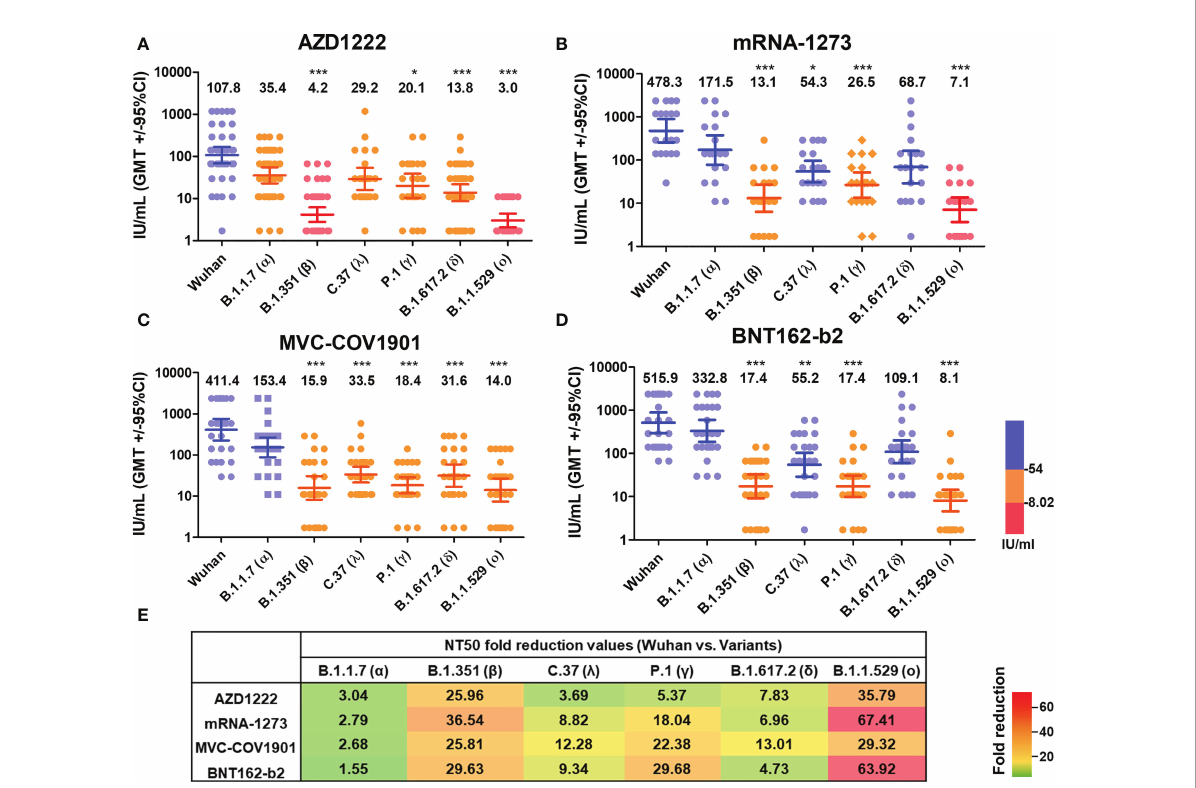
FIGURE 4 Neutralizing Ab response against different SARS-CoV-2 VOCs of different vaccine brands. (A) AZD1222, (B) mRNA-1273, (C) MVC-COV1901, and (D) BNT162-b2 vaccinees ’ sera were tested by pseudovirus micro-neutralization assay. Each sample ’ s neutralizing antibodies titer (NT50) against different SARS-CoV-2 VOCs was shown. Low neutralizing antibody response was red, medium neutralizing antibody response was orange, and high neutralizing antibody response was blue. (E) Values of fold-reduction in the neutralization of Alpha, Beta, Lambda, Gamma, Delta, and Omicron are presented as heat maps with colors. The statistical difference compared to the Wuhan strain was shown. *P<0.05, **P<0.01,